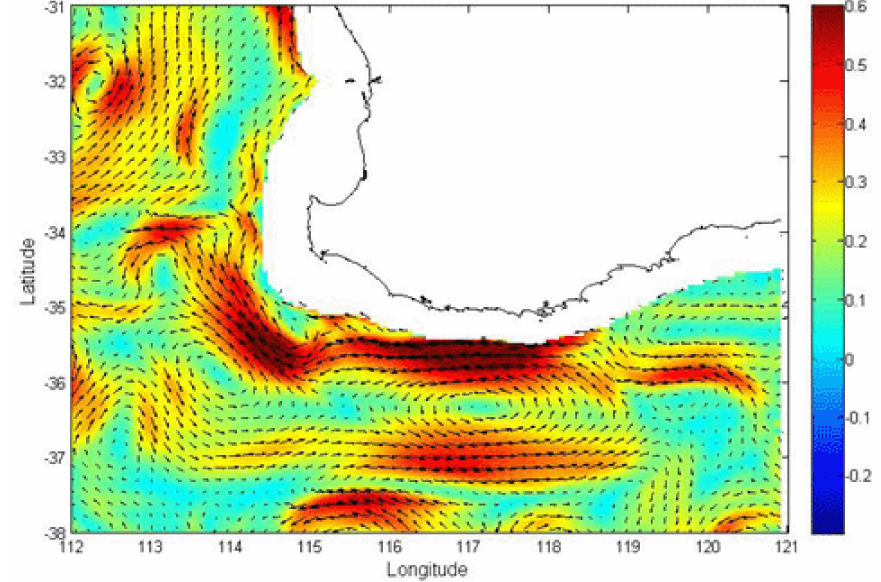
Figure 8. The velocity field at a depth of 550 m for the autumn. The colour bar indicates the velocity in ms − 1